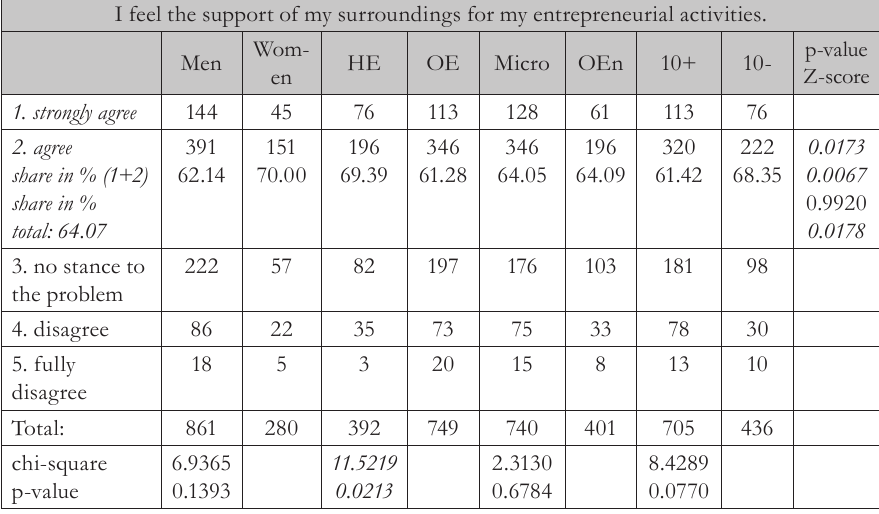
Tab. 2 - The perceived support of surrounding from the side of the entrepreneurs. Source: own source I feel the support of my surroundings for my entrepreneurial